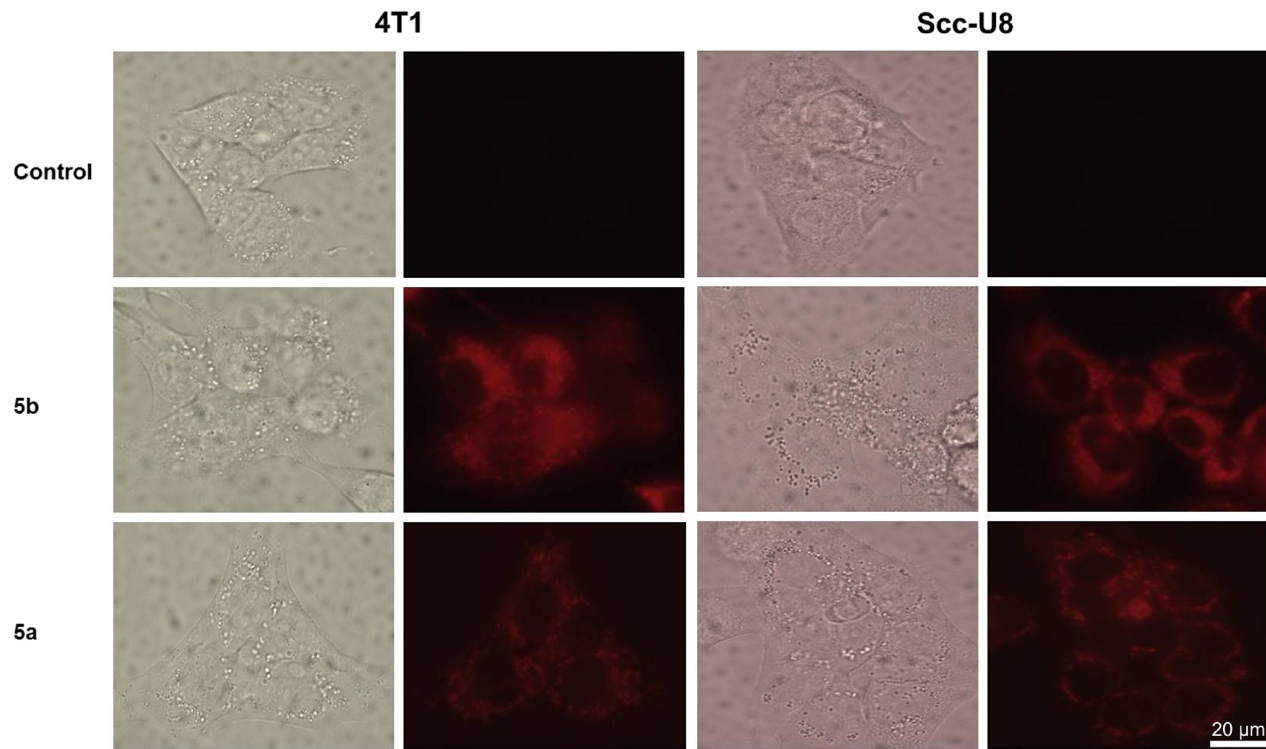
Figure 3. Cellular localization of PpIX derivatives, 5a and 5b , in 4T1 and Scc-U8 cells . Scale bar = 20 μ m.